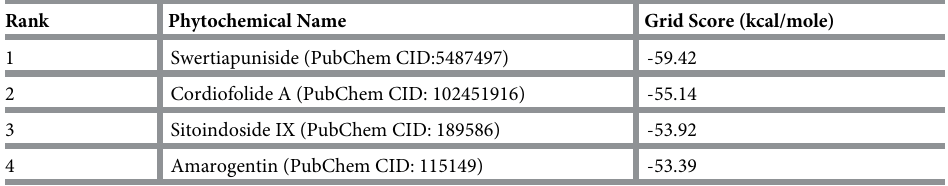
Table 2. Grid scores for the top-ranked four phytochemicals obtained through DOCK